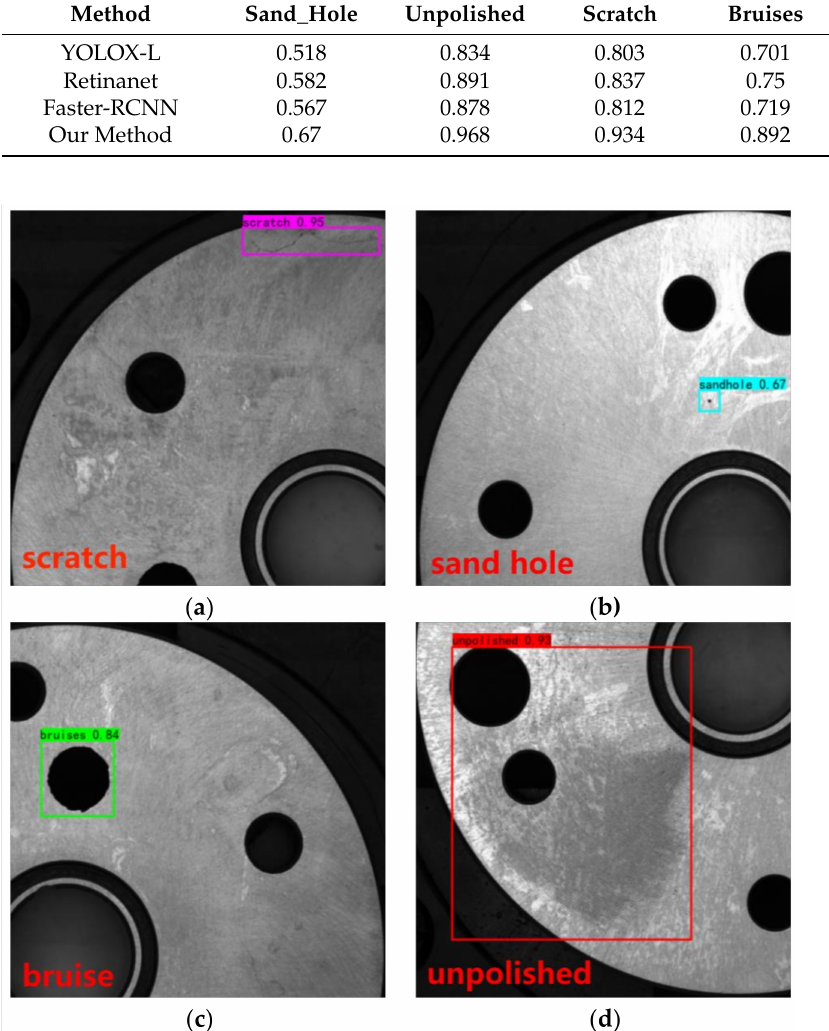
Figure 7. Results of flange surface defect detection. ( a ) Scratch, ( b ) sandhole, ( c ) bruises, ( d ) unpol- ished.